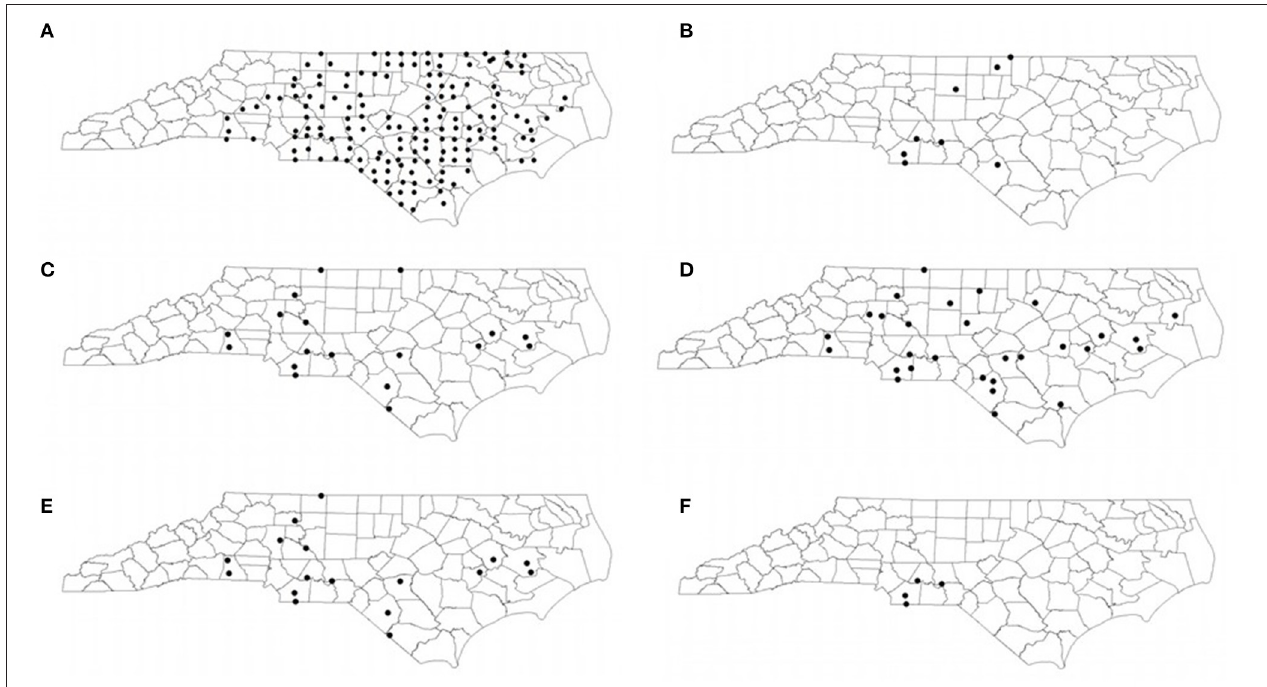
FIGURE 1 | (A) Distribution of the 155 sites sampled in North Carolina for putative herbicide-resistant Italian ryegrass in 2012 and 2013. All sampled Italian ryegrass populations have evolved resistance to diclofop applied at the maximum-labeled rate (acetyl CoA carboxylase-inhibiting herbicide). (B) Distribution of the eight North Carolina Italian ryegrass samples that have evolved resistance to pinoxaden applied at the maximum-labeled (acetyl CoA carboxylase-inhibiting herbicide). (C) Distribution of the 18 North Carolina Italian ryegrass populations that have evolved resistance to mesosulfuron applied at the maximum-labeled rate (acetolactate synthase-inhibiting herbicide). (D) Distribution of the 29 North Carolina Italian ryegrass populations that have evolved resistance to pyroxsulam applied at the maximum-labeled rate (acetolactate synthase-inhibiting herbicide). (E) Distribution of the 17 North Carolina Italian ryegrass populations that have evolved resistance to both acetolactate synthase-inhibiting herbicides applied at the maximum-labeled rate (mesosulfron and pyroxsulam). (F) Distribution of the four North Carolina Italian ryegrass samples that have evolved resistance to all tested acetyl CoA carboxylase (diclofop and pinoxaden)- and acetolactate synthase (mesosulfron and pyroxsulam)-inhibiting herbicides applied at the maximum-labeled